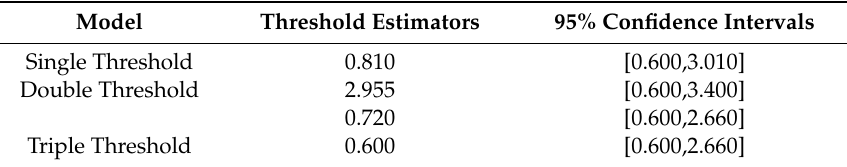
Table 3. Results of threshold estimators and confidence intervals.